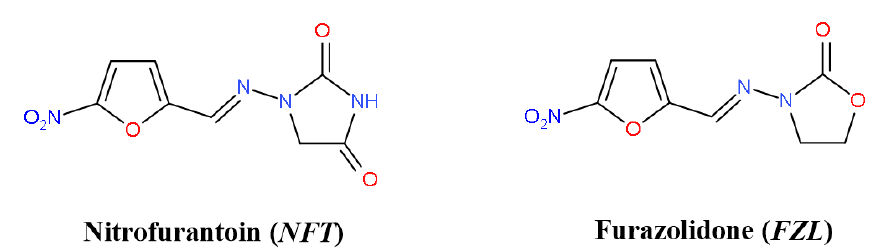
Figure 1. Chemical structures of nitrofurantoin and furazolidone.